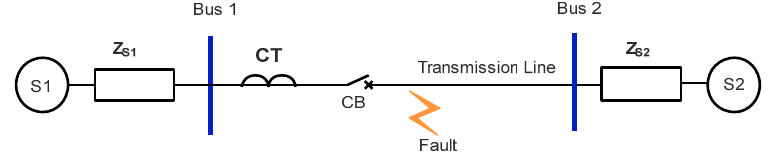
Figure 2. Simulated power system model in PSCAD.